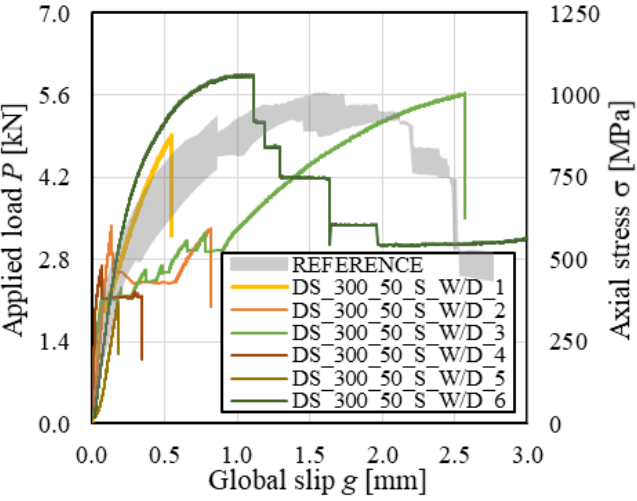
Figure 13. P-g responses of SRG-masonry joints.